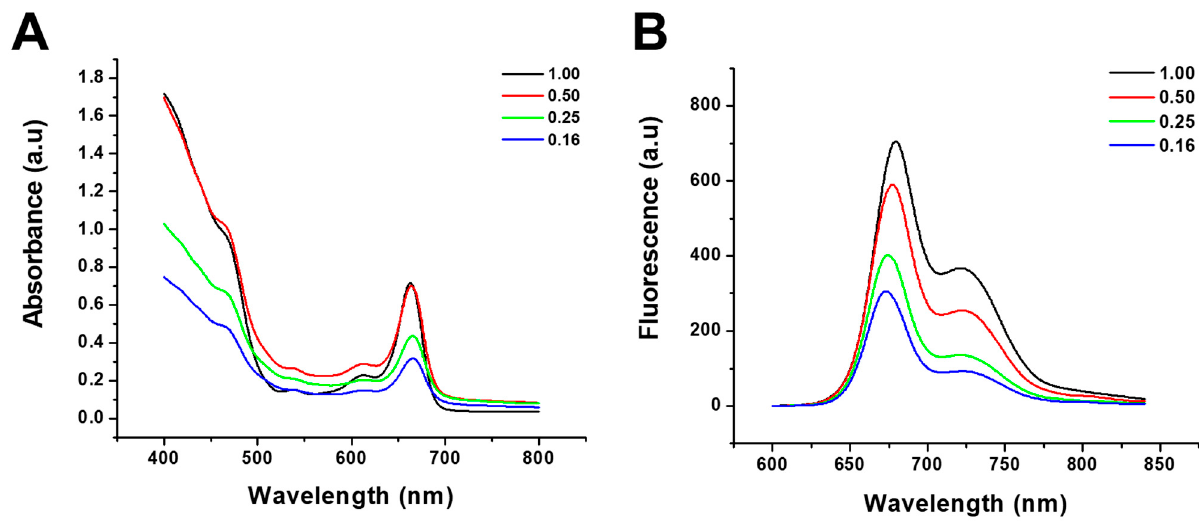
Figure 3. Optical properties of bay leaf extracts (concentration: 0.16–1.0 mg/mL). ( A ) Visible absorption spectra of bay leaf (400–800 nm) and ( B ) fluorescence spectra of bay leaf, excitation: λ ex, 405 nm and emission: λ em, 600–850 nm. Data are representative of a triplicate reading.